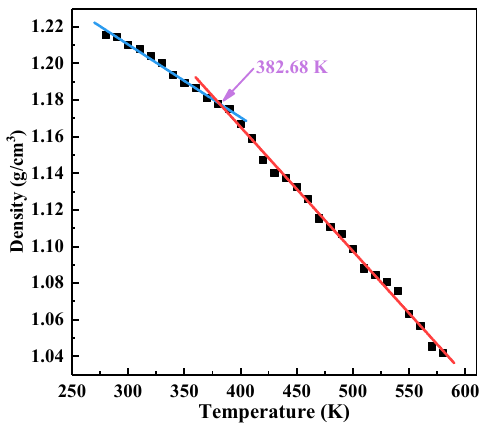
Figure 6. Linear fitting of the density-temperature curve in each system.